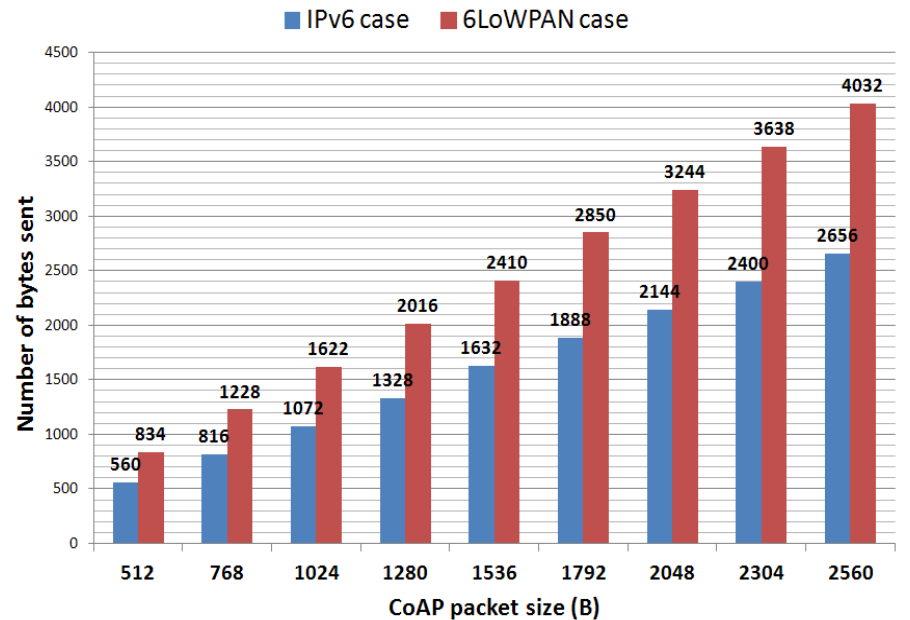
Figure 6. Number of bytes sent as a function of the CoAP packet